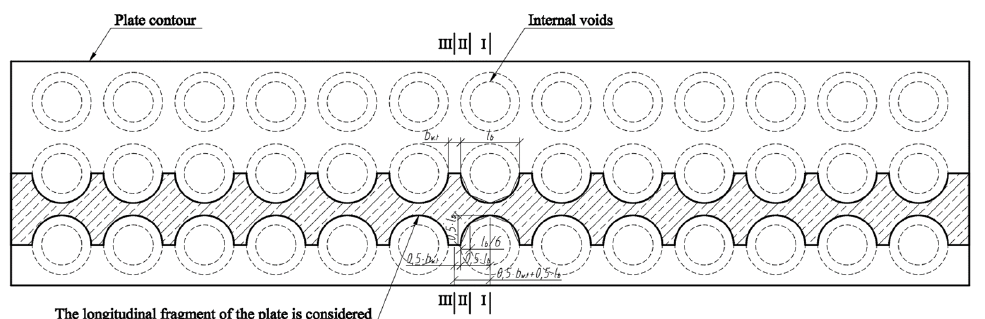
Figure 8. Slab scheme and sections.